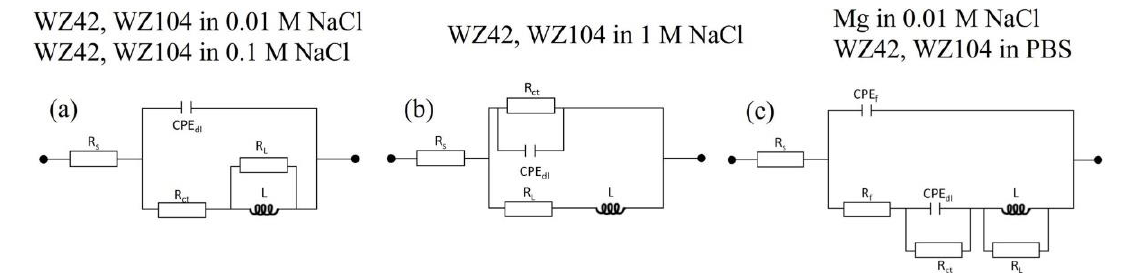
Figure 7. Equivalent electronic circuits used for data fitting of the investigated alloys after 1 h of immersion in various solutions: ( a ) WZ42, WZ104 in 0.01 M NaCl and WZ42, WZ104 in 0.1 M NaCl,